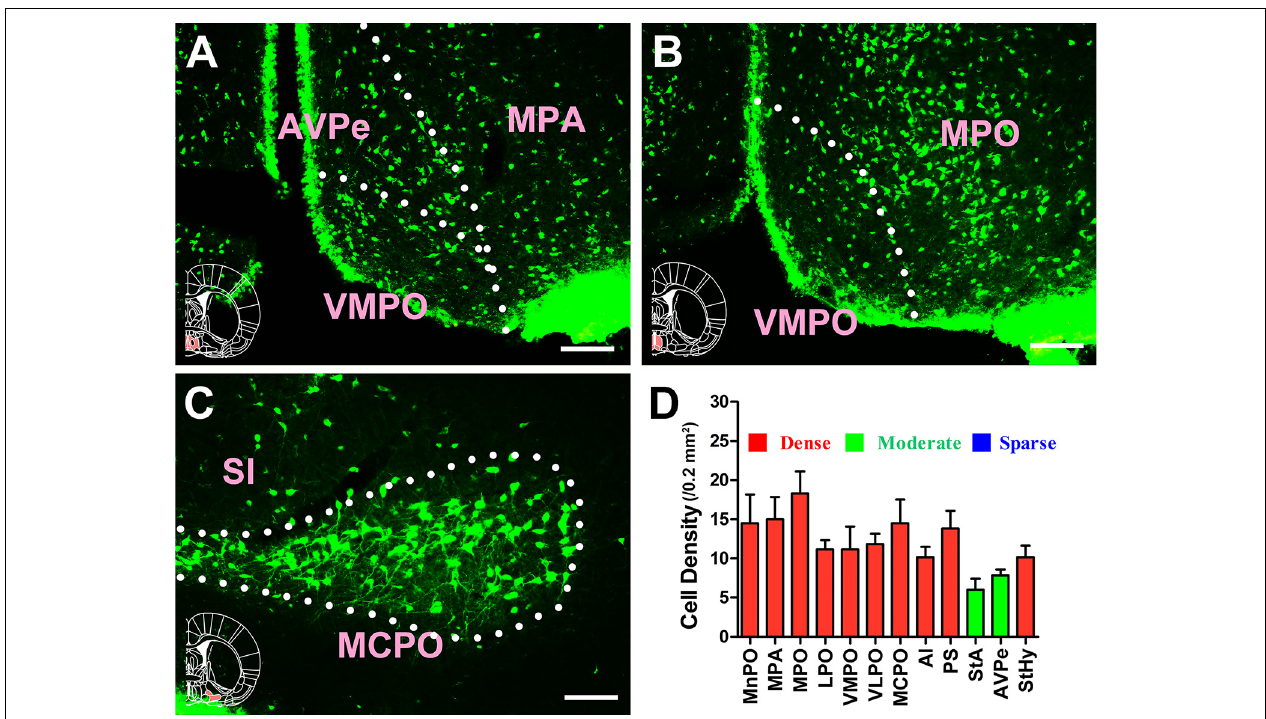
FIGURE 7 | Distribution of cholera toxin subunit B-positive neurons in the preoptic area Part II. (A–C) The positive neurons in AVPe, VMPO, MPA, MPO, MCPO, and SI. (D) Statistics of the input amounts of cholera toxin subunit B-positive cells from the preoptic area to the CSF-contacting nucleus (mean ± SD, n = 6; MPA, medial preoptic area; MPO, medial preoptic nucleus; AVPe, anteroventral periventricular nucleus; VMPO, ventromedial preoptic nucleus; SI, substantia innominata; MCPO, magnocellular preoptic nucleus). Bar = 100 µ